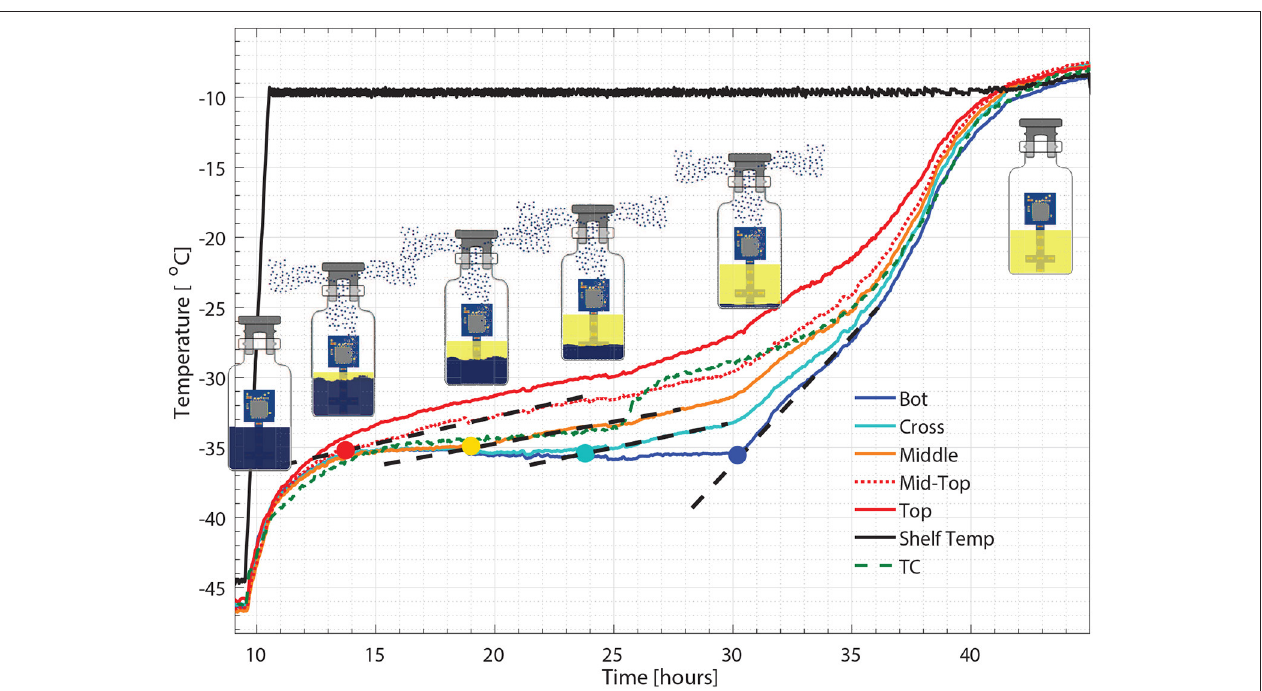
FIGURE 6 | Zoomed-in figure for primary drying phase Figure 5 , where each colored circle indicates the crossing point for the sublimation front with corresponding sensing point and the dash line represents the change of slope.